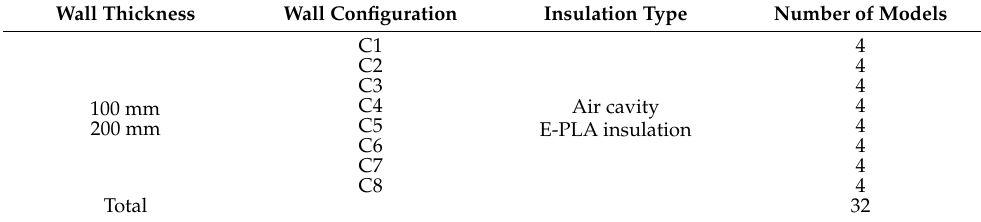
Table 3. Outline of the parametric study.